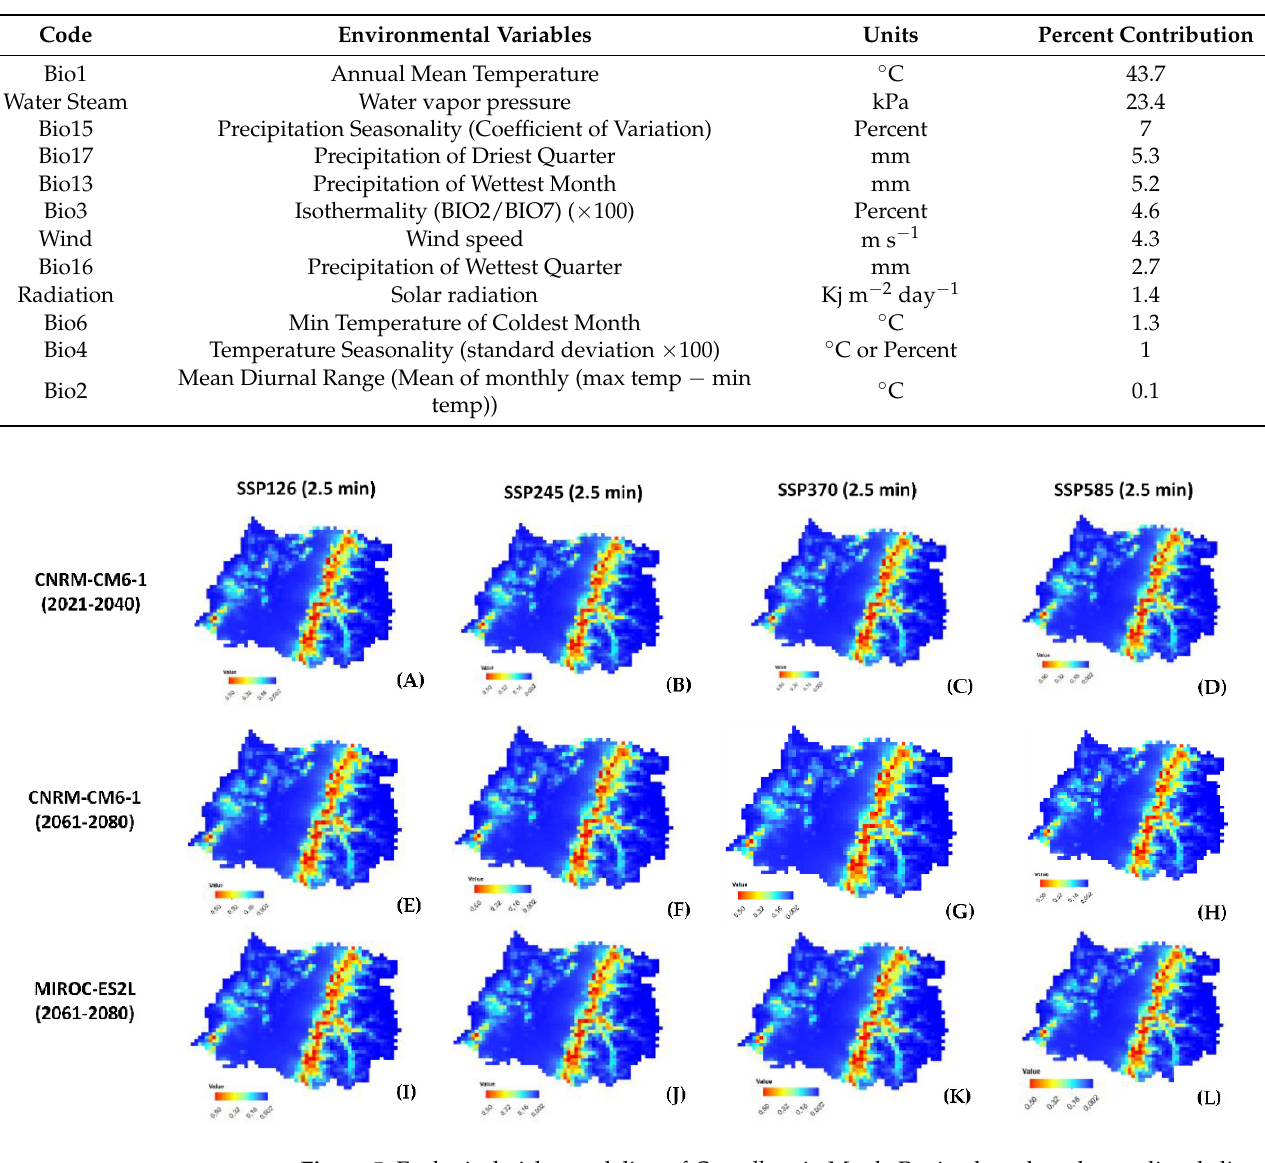
Table 2. Permutation importance of variables for the Maxent Model.